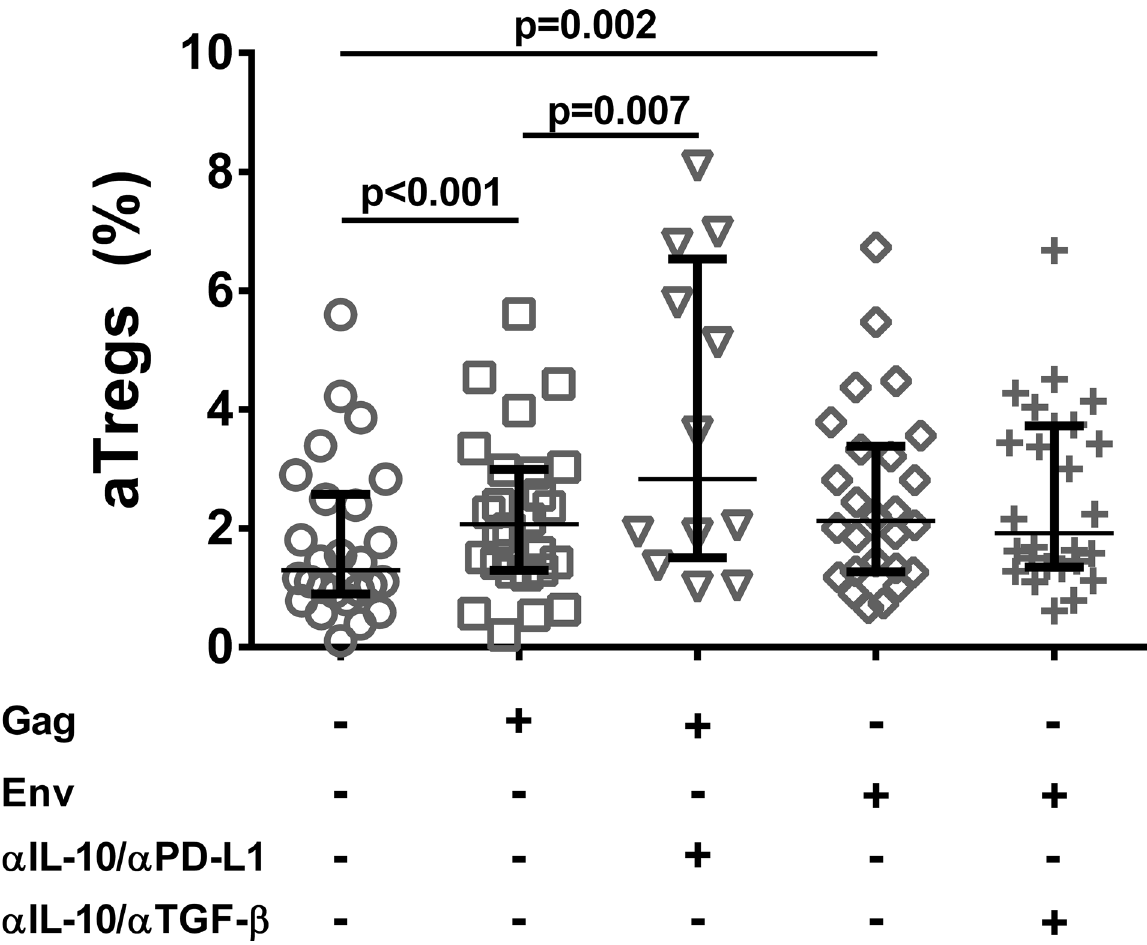
Fig 5. Increase in aTreg frequency after IL10/PD-1 dual blockade of Gag-stimulated cultures. Frequencies of activated regulatory T cells (CD25 hi CD45RA - ) in unstimulated cultures and in antigen-stimulated cultures with and without blocking antibodies. Median and upper/lower quartiles indicated. P-values derived from paired